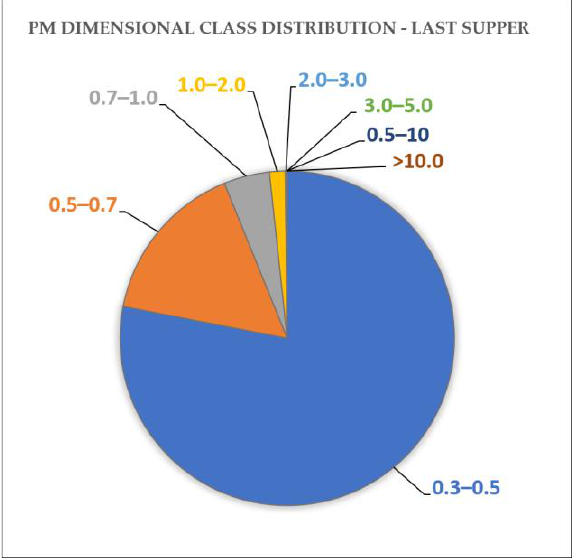
Figure 3. Dimensional class distribution of the particulate matter for the sampling site at the Last Supper . The ranges of the dimensional class are expressed in µ m.